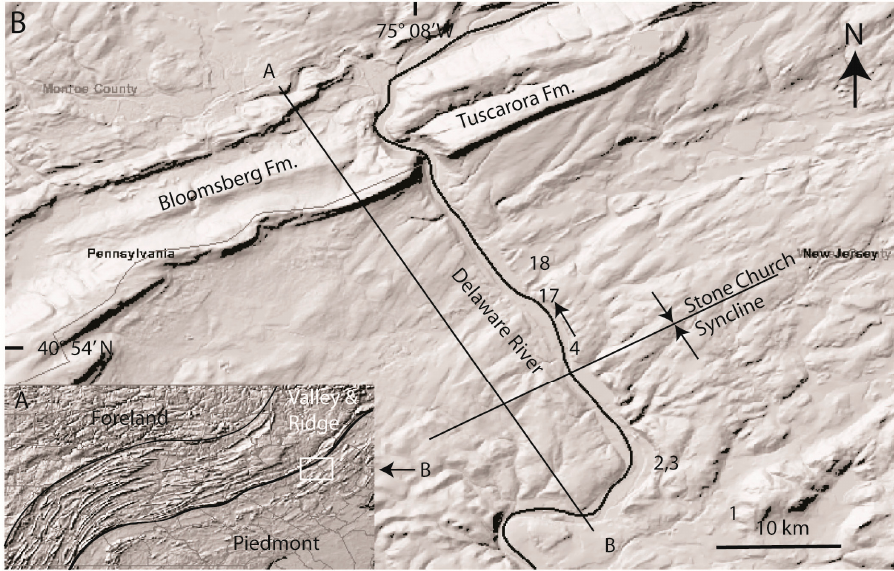
Figure 1. LIDAR base map of the Delaware Water Gap area (B) in New Jersey and Pennsylvania relative to the Appalachian Mountains (inset A with box for B). Sample sites are numbered. Cross section line (A-B) is from Maxwell [4] and in Figure 3; see also Herman et al. ([32], Figure 14 for regional subsurface structural relations).